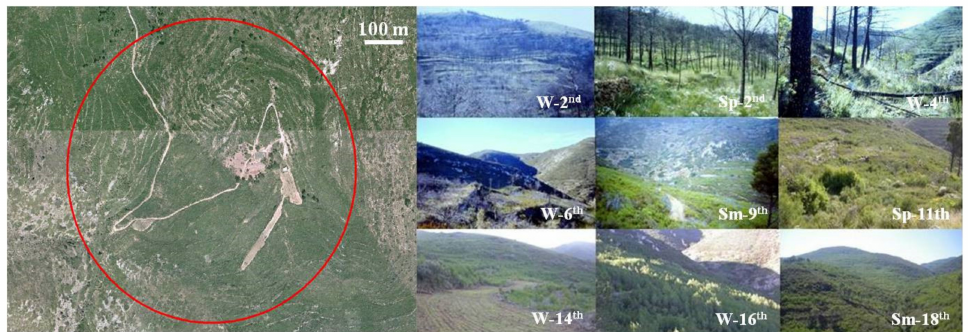
Figure 2. Orthophoto (courtesy of the Valencian Cartographic Institute) of the trapping site of La Saladilla (burned area) and some photographs showing its evolution during the post-fire regeneration process (W = Winter; Sp = Spring; Sm = Summer).